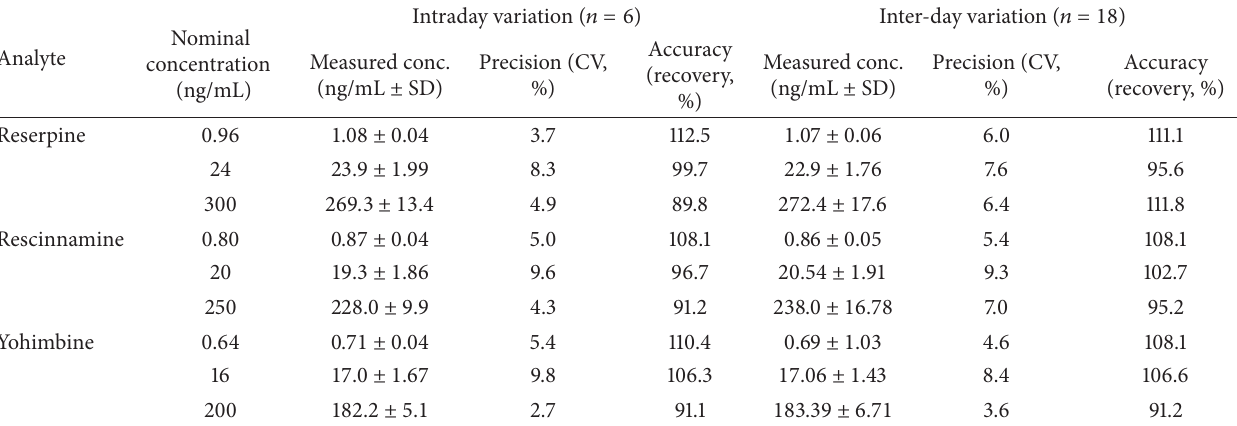
Table 1: Intra- and inter-day precision and accuracy of reserpine, rescinnamine and yohimbine in plasma. Nominal Analyte